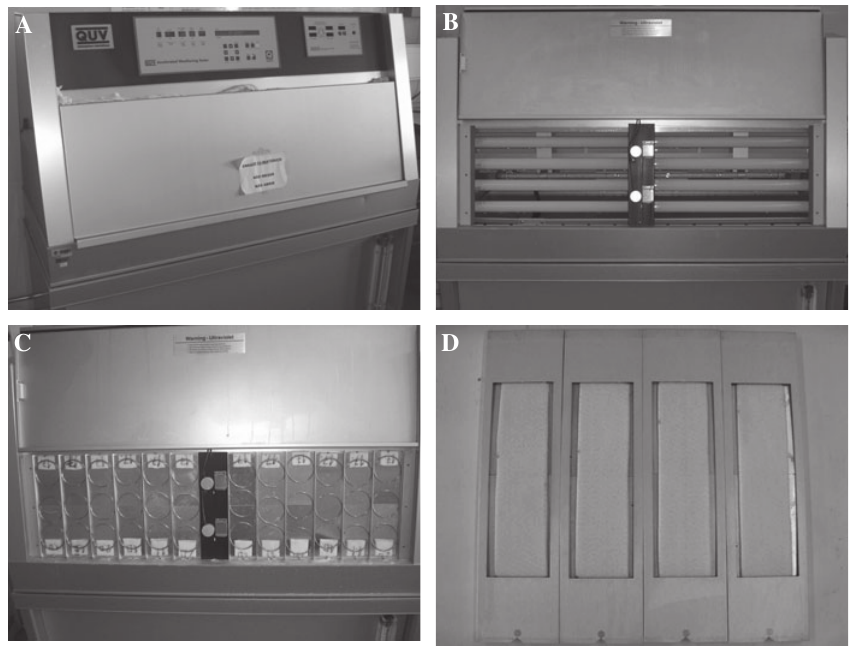
Figure 1 QUV Weathering Tester: (A) QUV closed; (B) QUV open (UV lamps), without specimen holders; (C) QUV open, with specimen holders; (D) specimen holders.